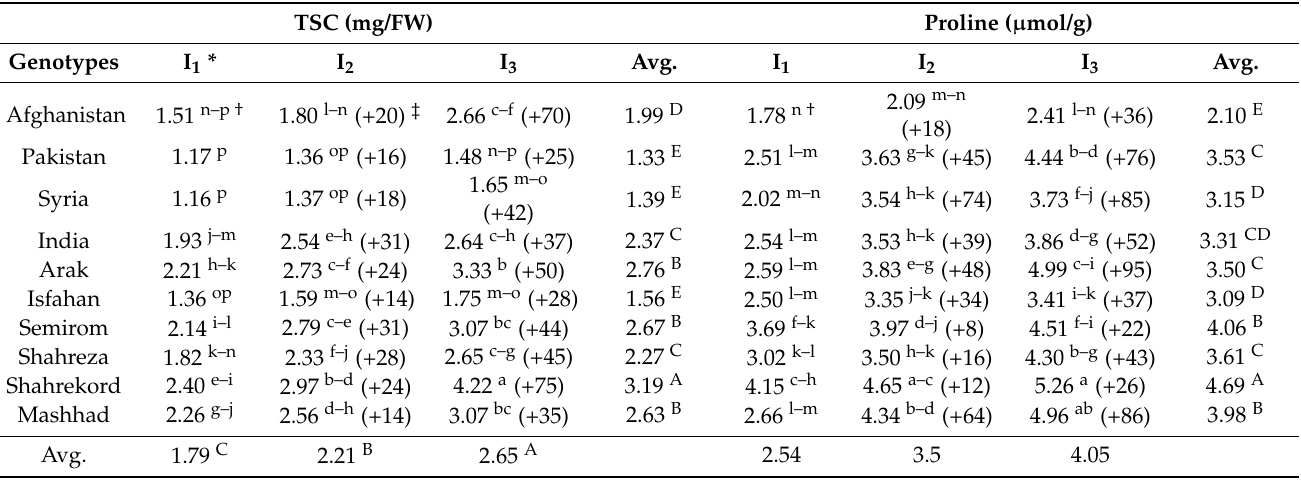
Table 5. Mean comparison of the effect of irrigation regime (I), genotype (G), and their interaction on TSC and proline of black